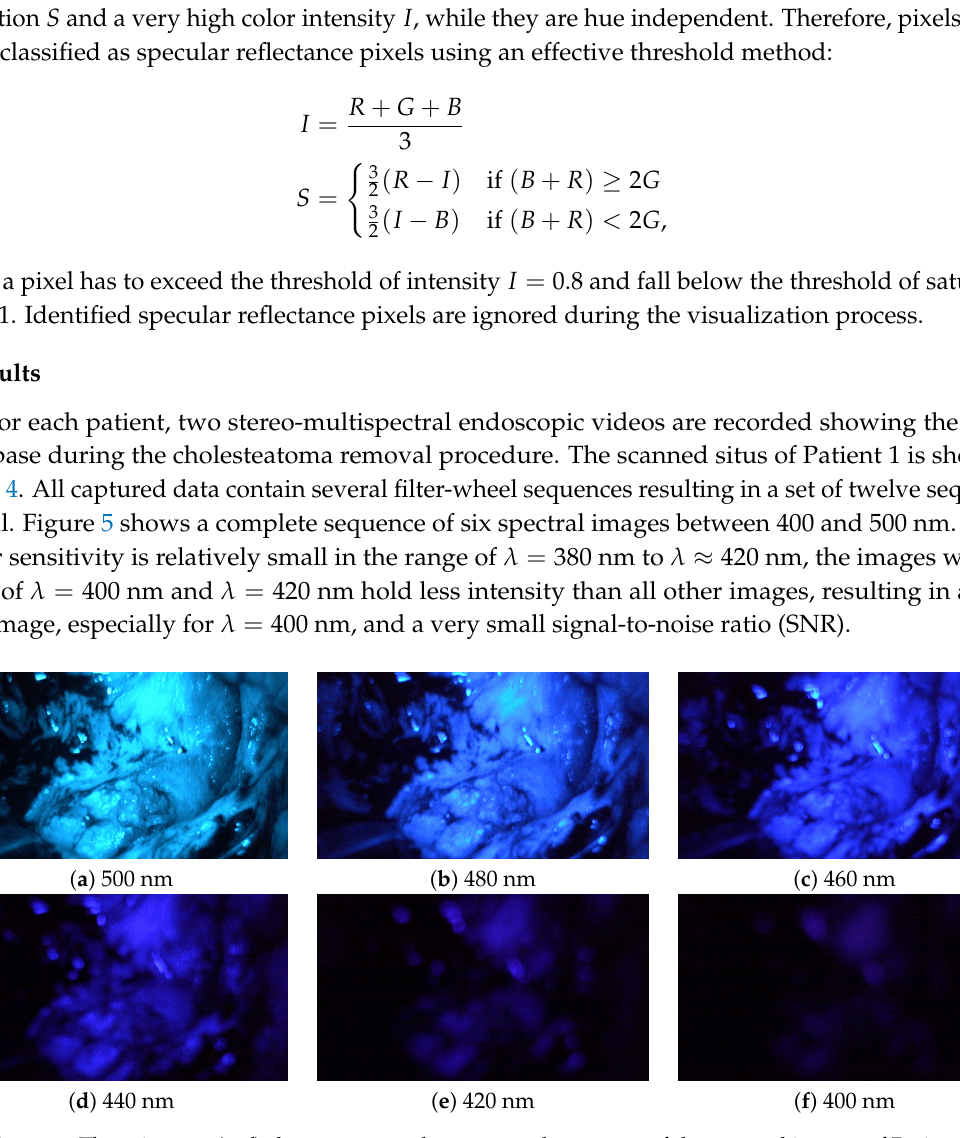
Figure 5. These images ( a – f ) show one complete captured sequence of the spectral images of Patient